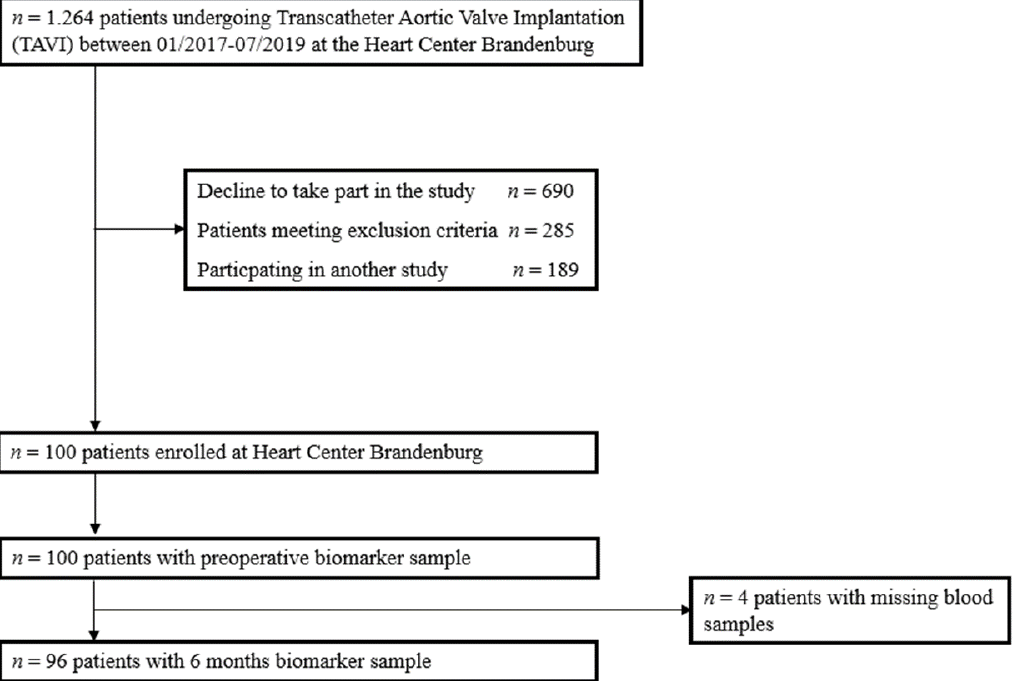
Figure 1. Patient flow through the study.